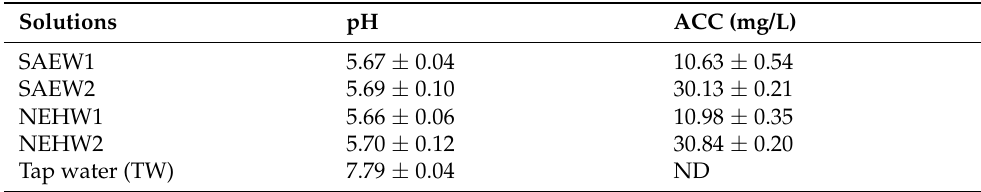
Table 1. a,b Chemical parameters of different solutions.